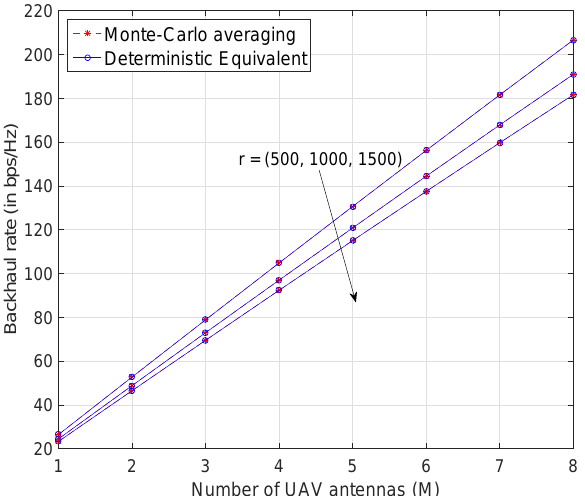
Figure 3. Comparison of ergodic backhaul rate and the deterministic equivalent versus the number of UAV antennas.